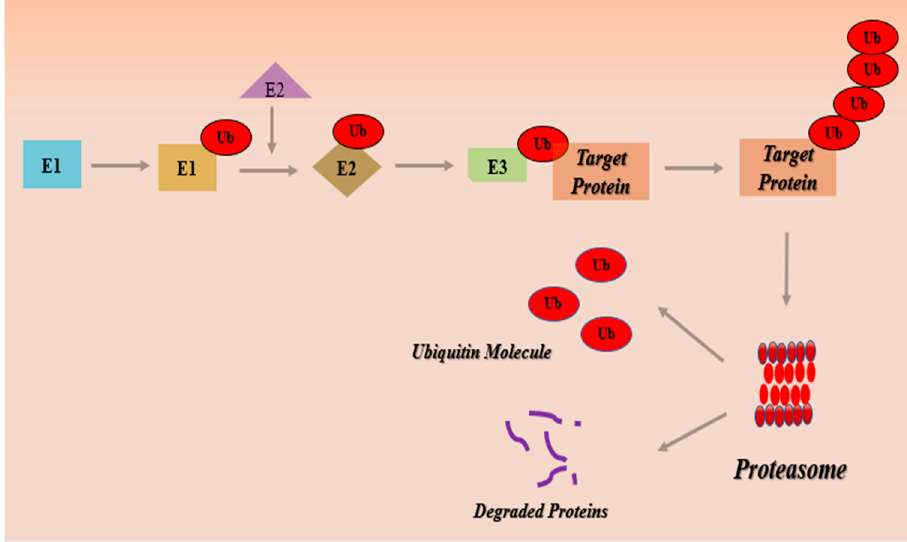
Figure 1. Ubiquitin-proteasome pathway.